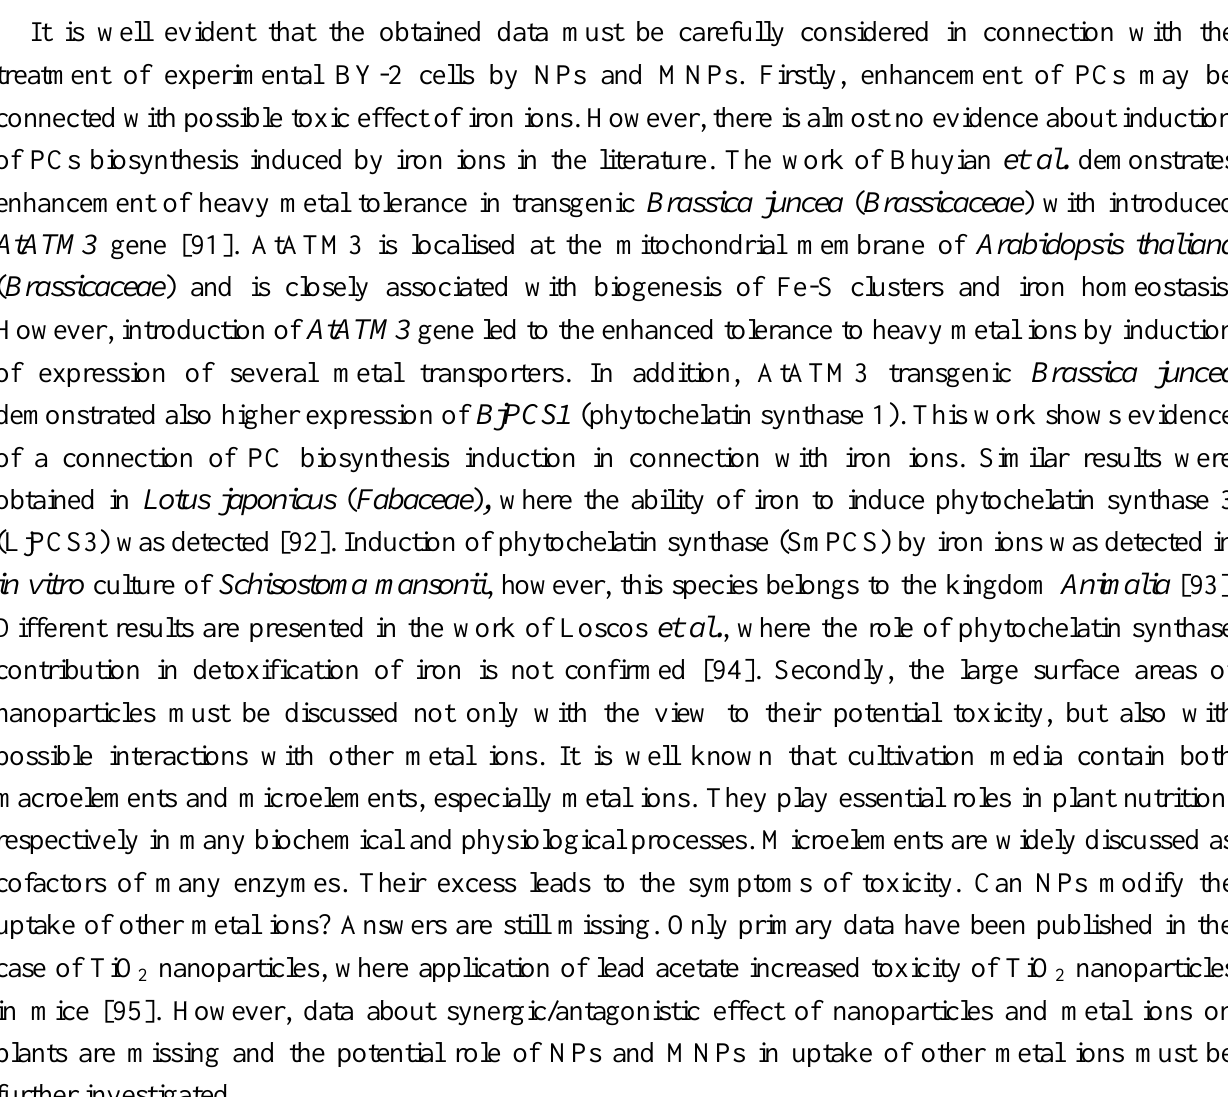
O nanoparticles 2 3 O -OH and Fe O -NH ) on 2 3 2 3 2